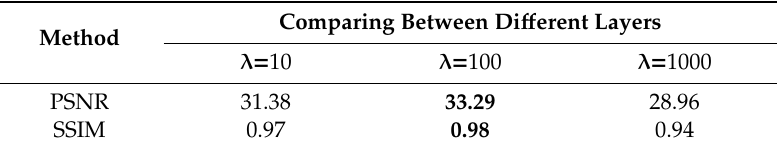
Table 7. PSNR and SSIM of di ff erent lambda on GOPRO Large